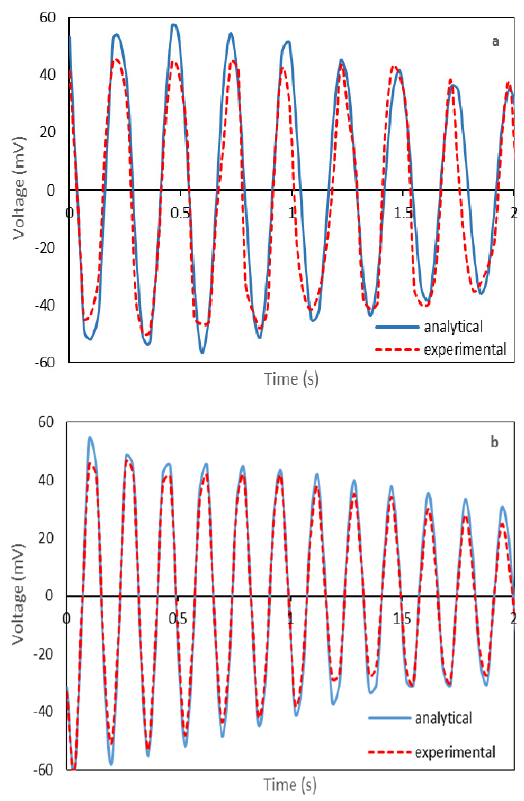
Figure 11. Comparison of the analytical and experimental output voltage at a frequency of a. 4 Hz b. 6